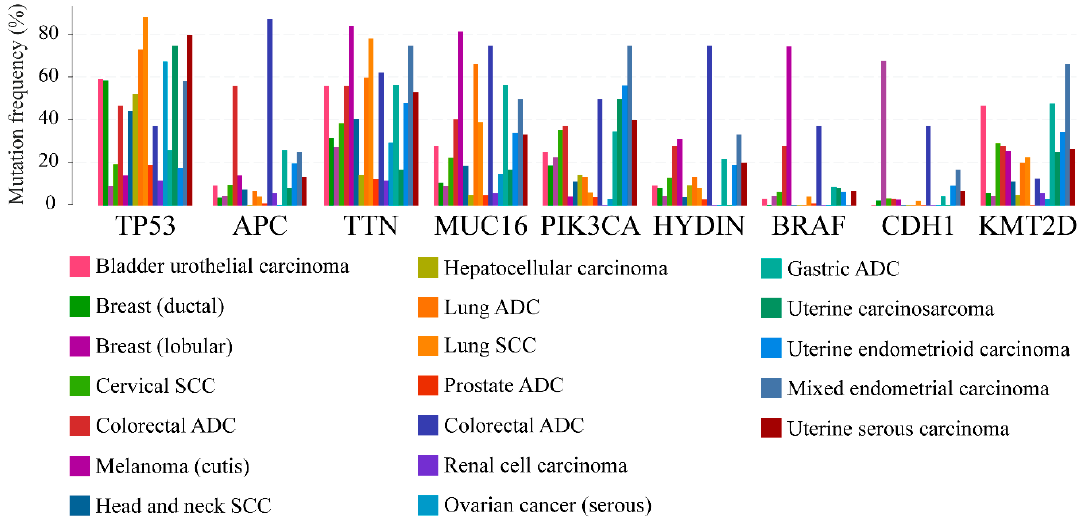
Figure 8. Frequency of mutations targeting the highly recurrent mutated genes in PTEN-defective solid tumors. Each tumor type is color-coded on the basis of the legend on the bottom. ADC, adenocarcinoma; SCC, squamous cell carcinoma.